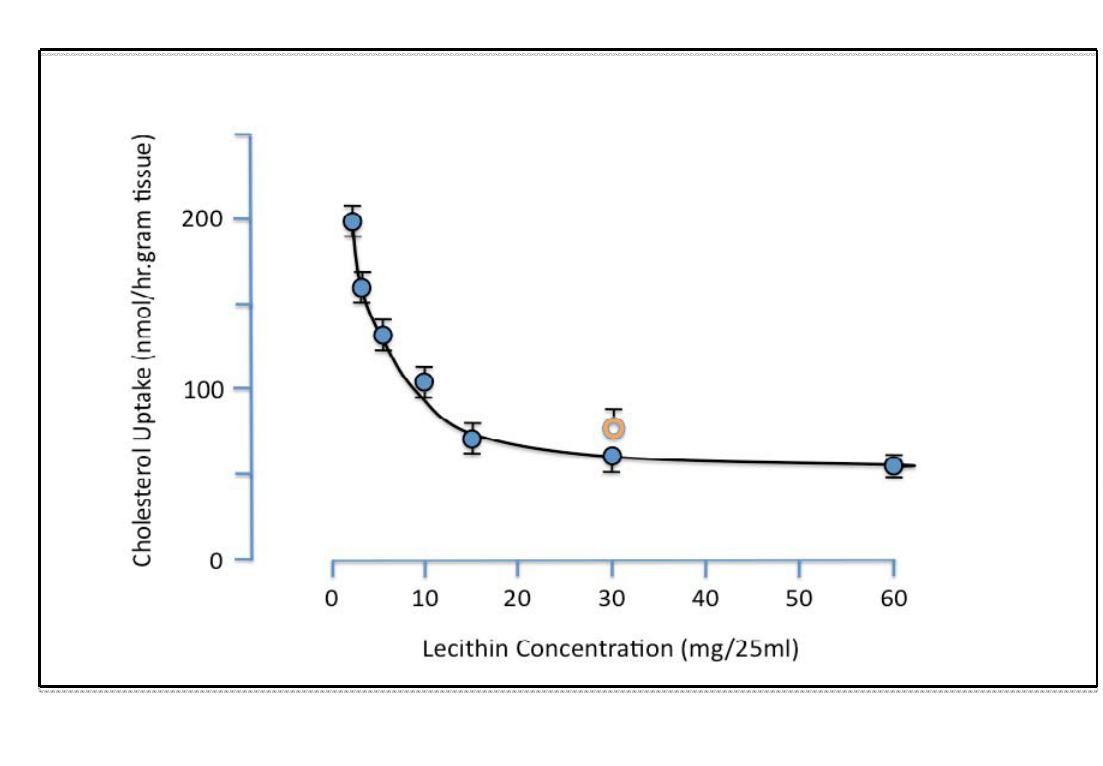
Figure 1. Effect of liver lecithin on intestinal uptake of micellar cholesterol. Everted rat gut sacs were incubated at 37 o C for 1 hr in 25ml micellar solution containing 0.15 mM cholesterol and 4.8 mM bile salt with various amounts of added lecithin. Orange ring symbol represents data obtained with egg lecithin replacing liver lecithin. Each point is the mean of 4–8 experiments. Vertical bars are SE (reproduced from ref.